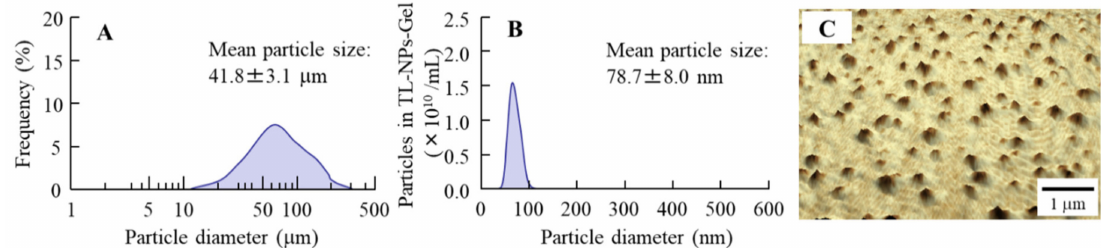
Figure 1. Size distribution of TL in TL-MPs-Gel and TL-NPs-Gel. ( A ) solid TL size in TL-MPs-Gel by SALD-7100. ( B ) solid TL size in TL-NPs-Gel by NANOSIGHT LM10. ( C ) AFM image of solid TL in TL-NPs-Gel. The TL nanoparticles were obtained by bead mill treatment at a particle size range of 50-100